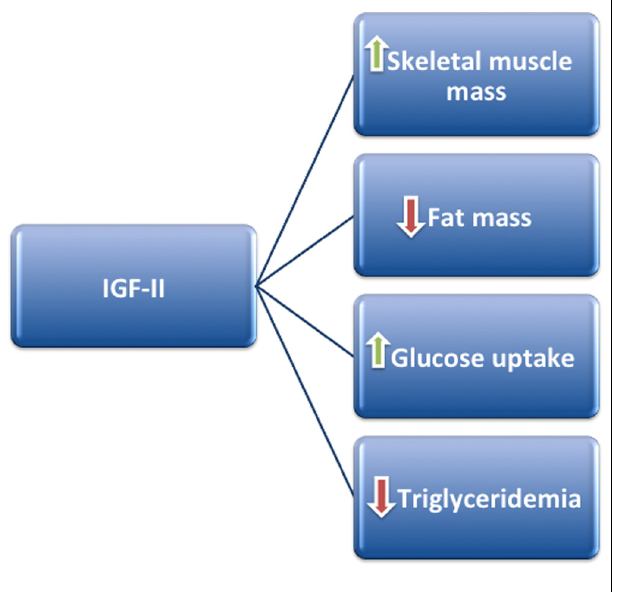
FIGURE 1 | IGF-II may positively regulate metabolism by stimulating skeletal muscle mass accrual and glucose uptake, at the same time decreasing fat mass and triglyceride